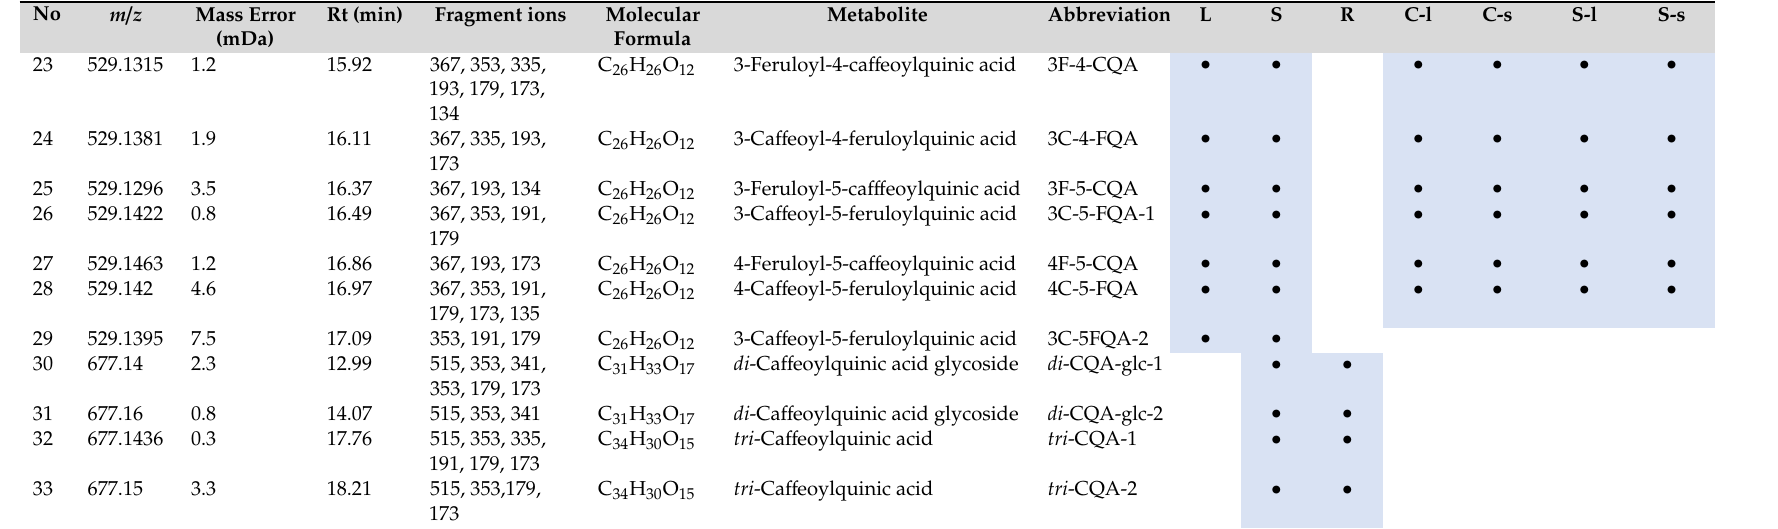
* Shaded squares indicates presence of